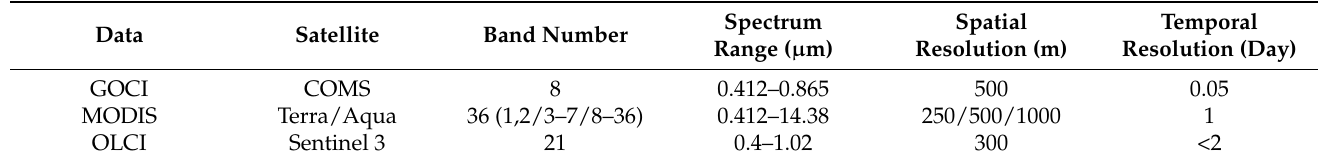
Table 1. Parameters of the GOCI, MODIS and OLCI satellite sensors.